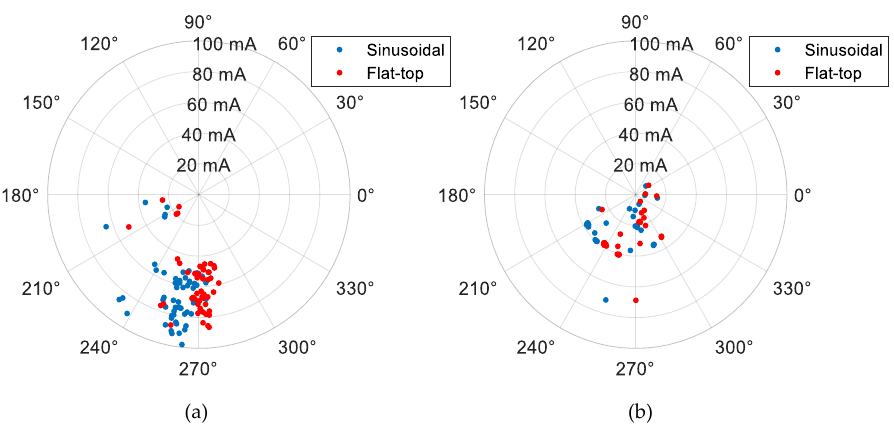
Figure A2. Third harmonic current emission of the selected lamps under the two types of supply voltage: ( a ) CFL and ( b ) LED lamps.